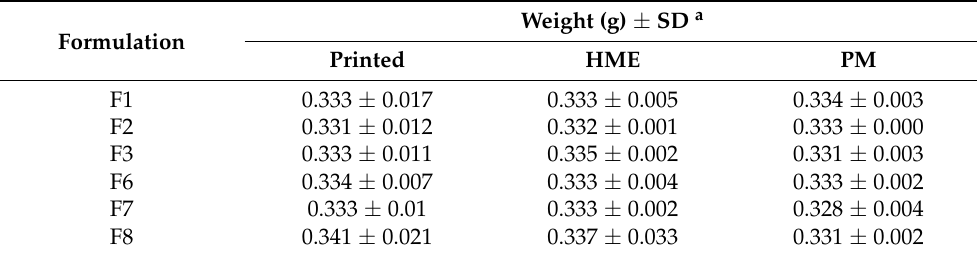
Table 3. Weight values of tablets made via different techniques.